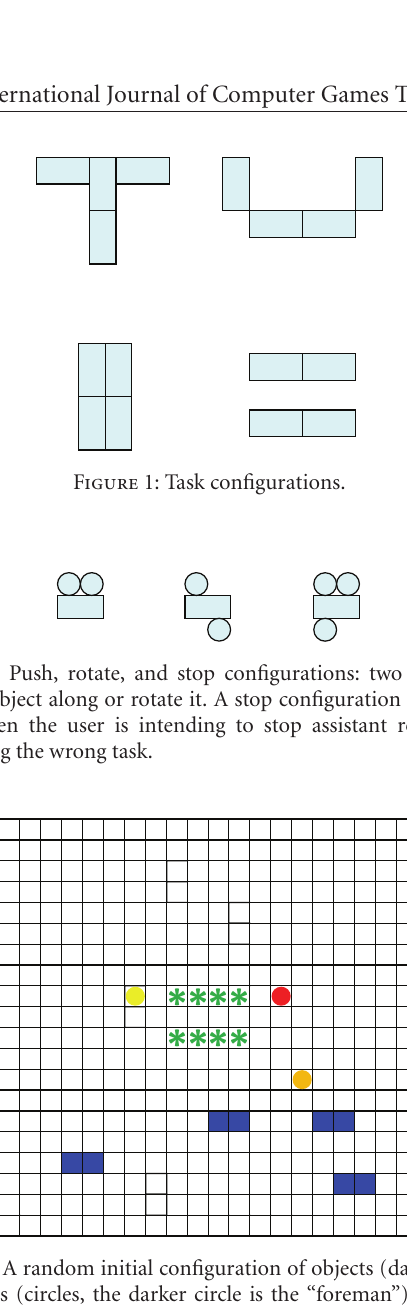
Figure 3: A random initial configuration of objects (dark squares) and robots (circles, the darker circle is the “foreman”) and target configuration